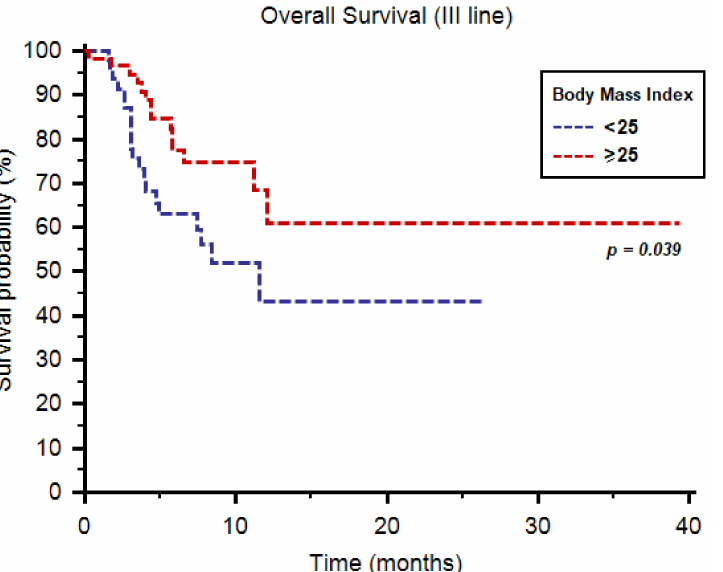
Figure 4. Overall survival of patients receiving cabozantinib as third-line therapy stratified by body mass